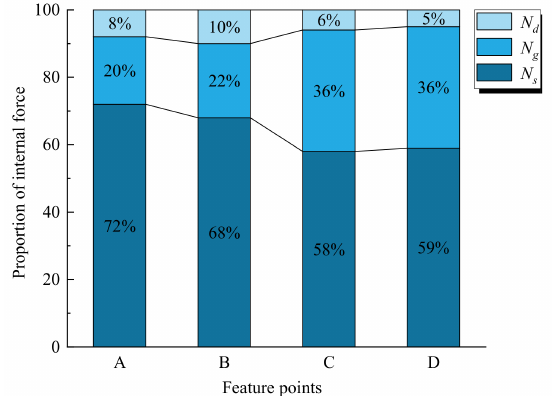
Figure 14. Proportion of internal force at key loading